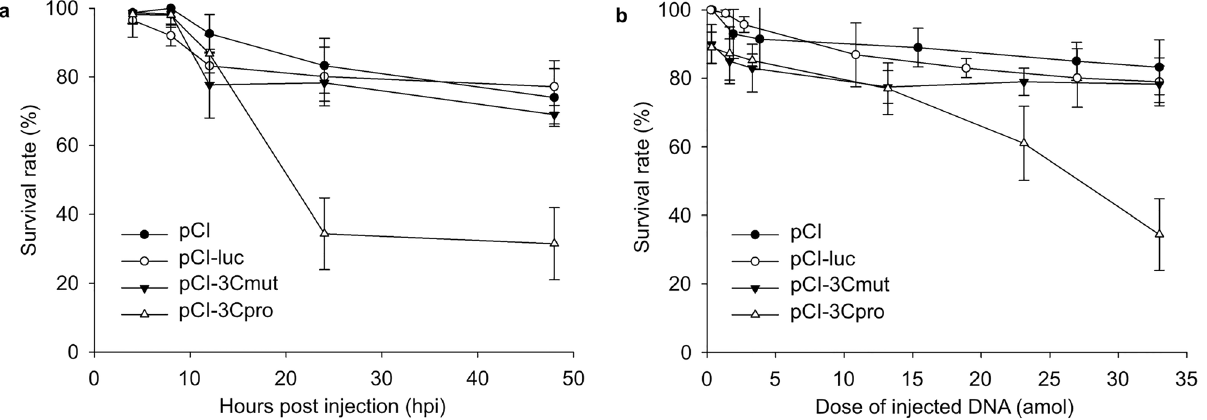
Figure 3. Survival of Danio rerio after the injection of DNA constructs. ( a ) Abscissa, time after injection, h; ordinate, number of survived embryos in animal groups injected with 33 attomoles of pCI, pCI-luc, pCI-3Cmut, and pCI-3Cpro. The rate of survived embryos was calculated relative to the number of injected fertilized eggs in each experiment minus the proportion of dead control embryos injected with the buffer solution. Significant ( p < 0.001) effects induced by pCI-3Cpro relative to pCI, pCI-luc, and pCI-3Cmut were observed 24 and 48 h after injection. The survival rates for each vector used are given as the mean for six independent experiments each with 50 injected fertilized eggs ± SD. ( b ) Abscissa, DNA quantity (attomoles) of injected pCI, pCI-luc, pCI-3Cmut, and pCI-3Cpro. Ordinate, the survival rate of embryos 24 h after DNA injection. The rate of survived embryos was calculated relative to the number of injected fertilized eggs in each experiment minus the proportion of dead control embryos injected with the buffer solution. Significant differences were observed after the injection of 23 ( p < 0.05) and 33 attomoles ( p < 0.001) of pCI-3Cpro relative to pCI, pCI-luc, and pCI- 3Cmut. The survival rates for each dose of administered vector DNA are given as the mean for six independent experiments each with 50 injected fertilized eggs ±